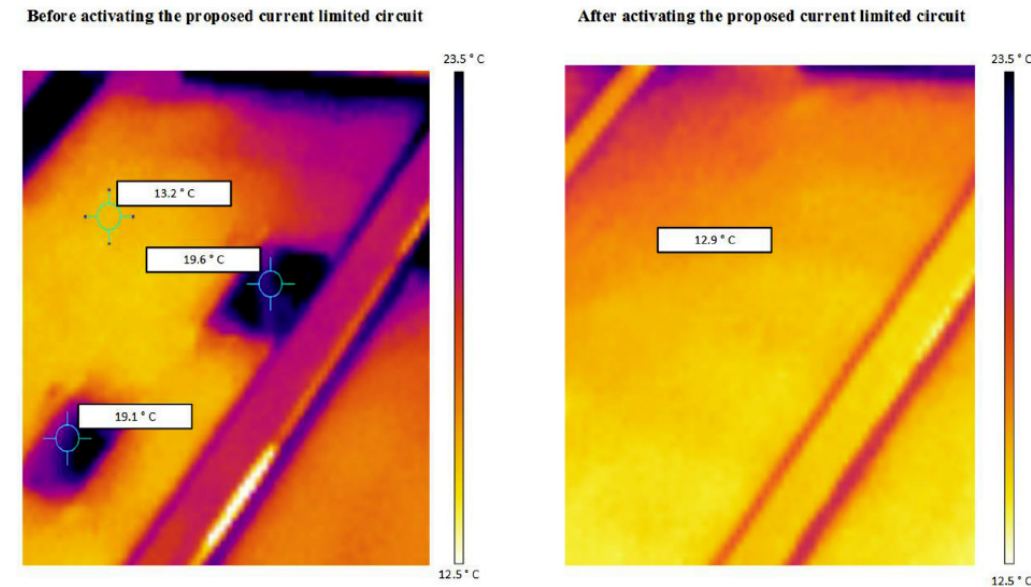
Figure 11. Impact of hotspot mitigation technique developed by [112] on a PV module affected by two shaded solar cells.